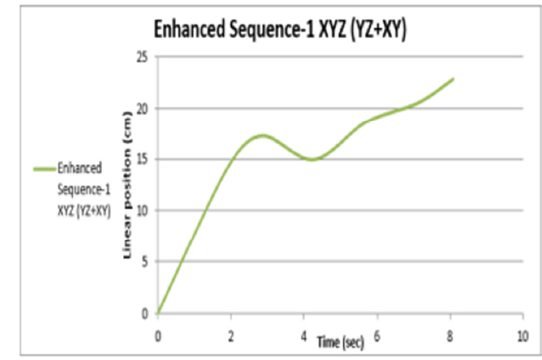
Fig. 14. Enhanced sequence XYZ (YZ+XY) for the first obstacle.